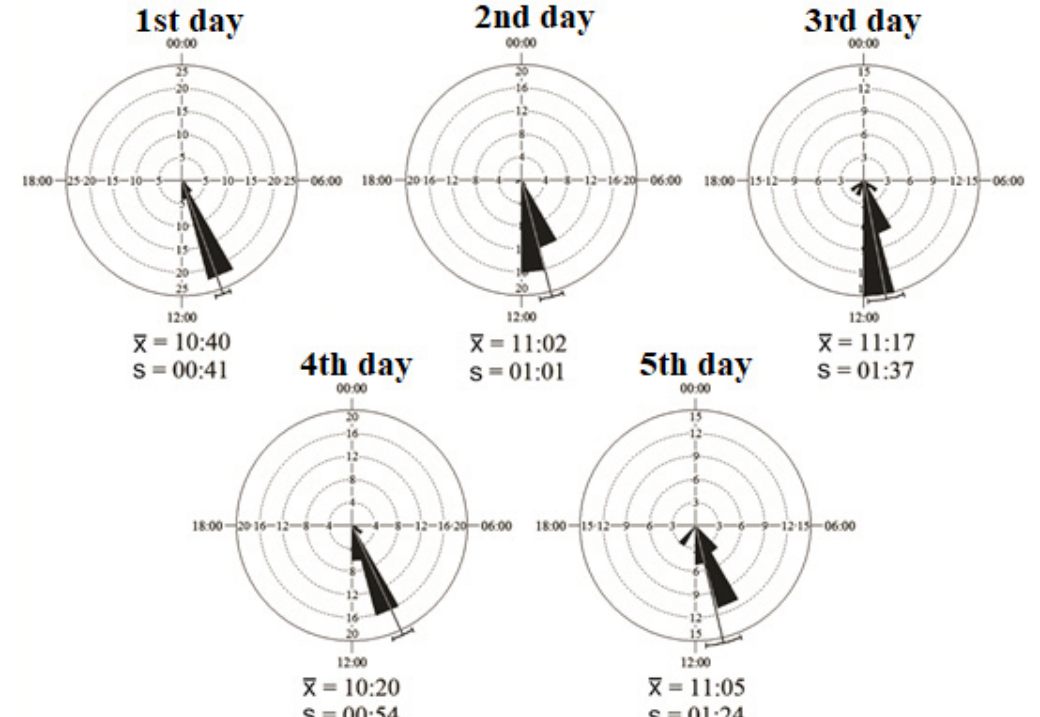
Fig 3 . Time of the last visits of forages of M. subnitida to an artificial feeder on each experimental day. The length of the sections indicates the number of bees in the corresponding time range. The radial line indicates the average time of the last occurrence (  ) and the line perpendicular to this indicates the circular standard deviation ( S